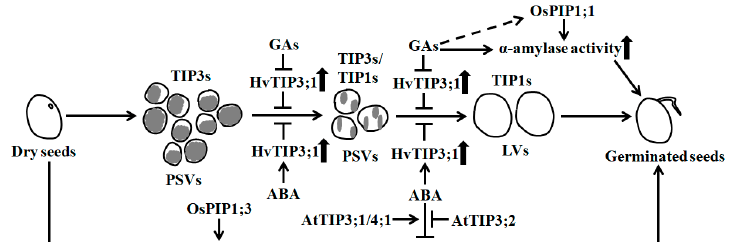
Figure 1. Aquaporins are required for the germination of orthodox seeds through a ff ecting vacuolation and α -amylase activity. During seed germination, vacuolation occurs. TIP3s are enriched in small protein storage vacuoles (PSVs), whereas TIP1s accumulate in large vacuoles (LV). TIP3s negatively a ff ect the formation of LVs. Gibberellins (GAs) activate α -amylase activity and promote the conversion of PSVs to LVs by inhibiting HvTIP3;1 expression, but abscisic acid (ABA) has the opposite e ff ect during barley seed germination [38]. AtTIP3;1 and AtTIP4;1 have positive e ff ects, whereas AtTIP3;2 has negative e ff ects on ABA-inhibited seed germination [39]. Rice OsPIP1;1 has a beneficial role in seed germination by inducing α -amylase activity, and OsPIP1;3 plays a positive role during seed germination [35]. Long solid arrows show the transition of seed germination, and short and thick up arrows indicate increases in the abundance of HvTIP3;1 and the activities of α -amylase. Short and thin solid arrows reveal positive regulation, and bars represent negative regulation. The dotted arrow represents unidentified regulation and the gray in PSVs shows the storage